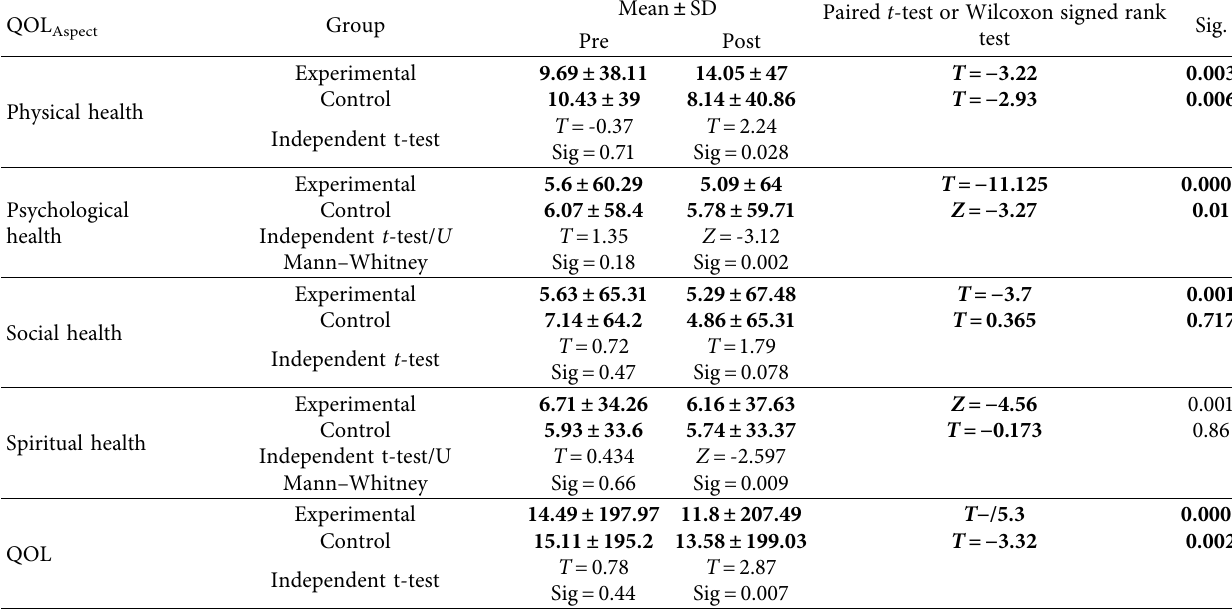
Table 3: Comparison of mean scores of QOL and its subscales in clients of the experimental and control groups before and after